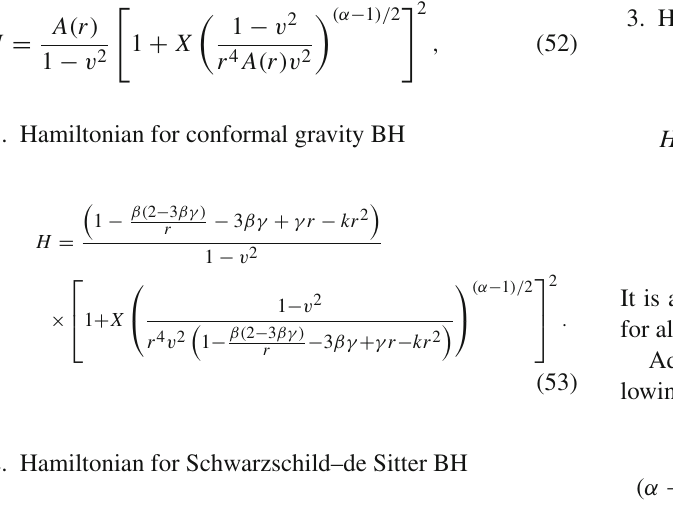
= 0 . 5773, H ≈ 1 . 95007.Rightpanel(Schwarzschild–deSitterBH) c c